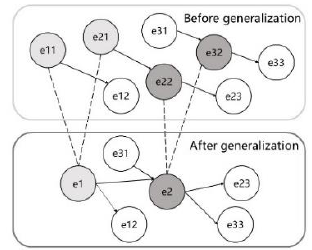
Figure 5 . Event chain generalization.